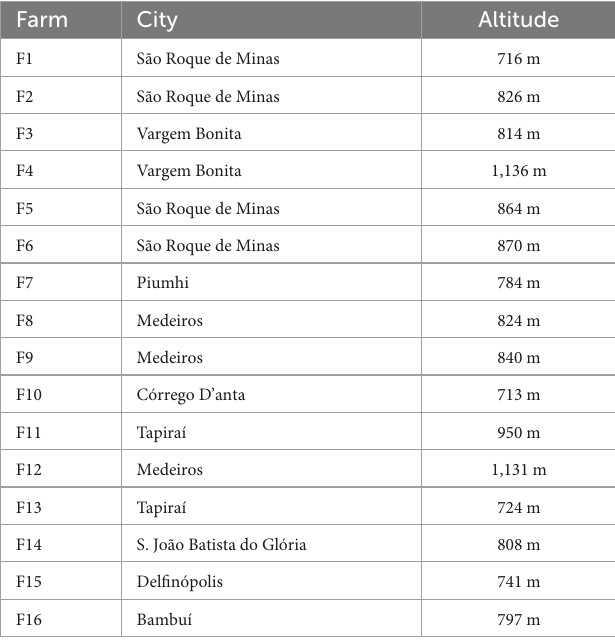
TABLE 1 Metadata for the 16 Canastra cheese’s producers where the samples were